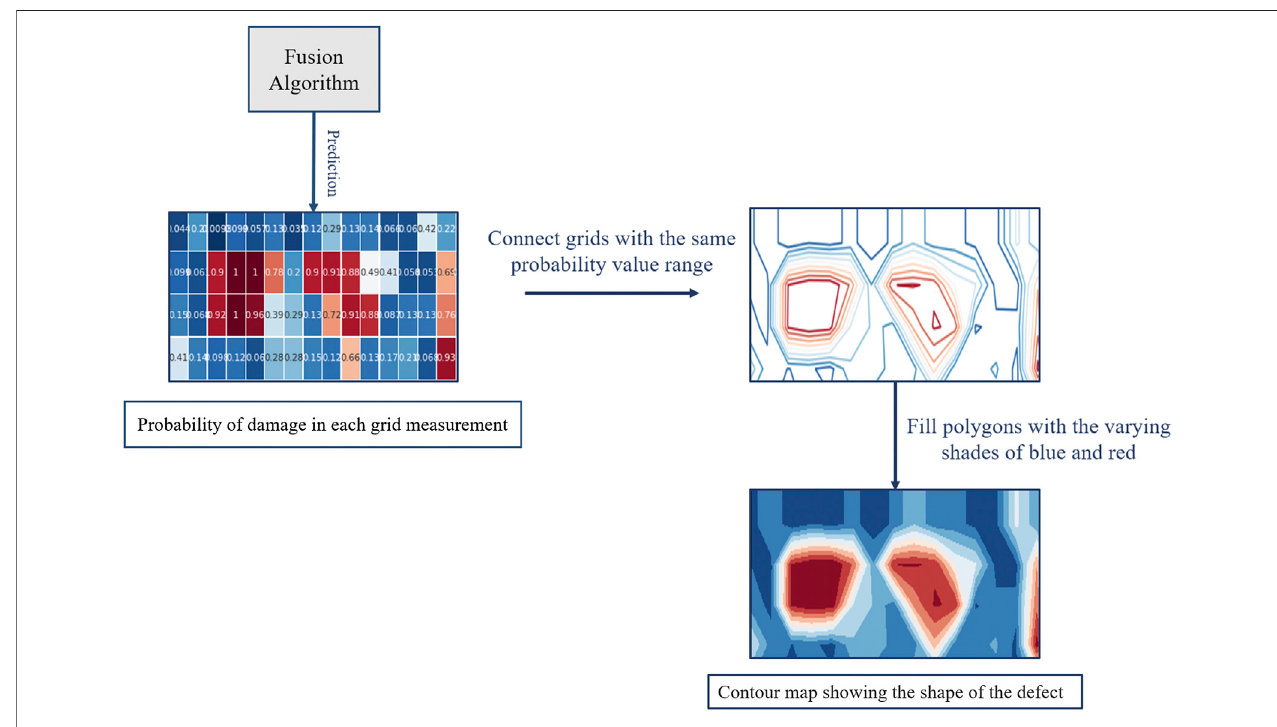
FIGURE 8 | Flowchart of the process for generating fusion con fi dence visualizations.